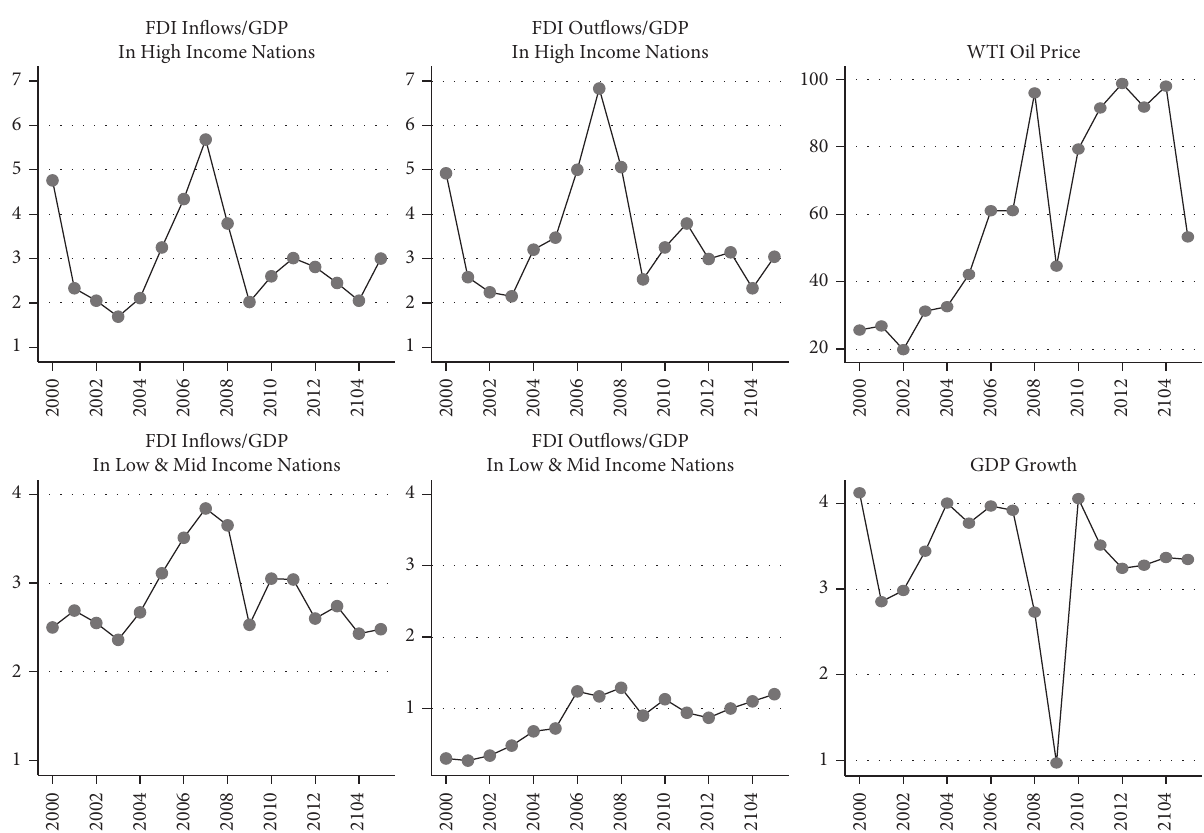
Figure 2: World trends. Source: FDI inflows/GDP and FDI outflows/GDP in high-, mid-, and low-income nations are available in World Development Indicators (WDI). The WTI oil price and real GDP growth are collected from